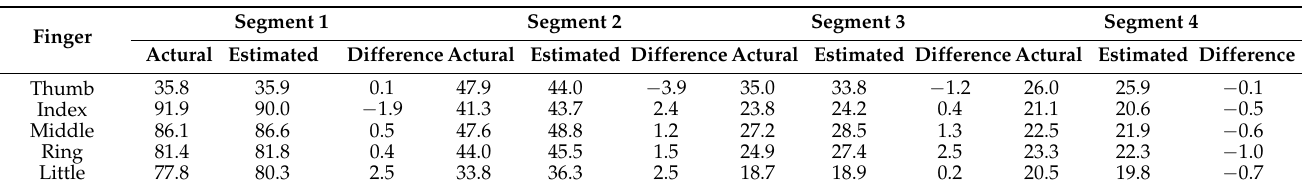
Table 4. Differences between the internal hand link lengths estimated from the proposed regression models and the actural internal hand link lengths (unit: mm).